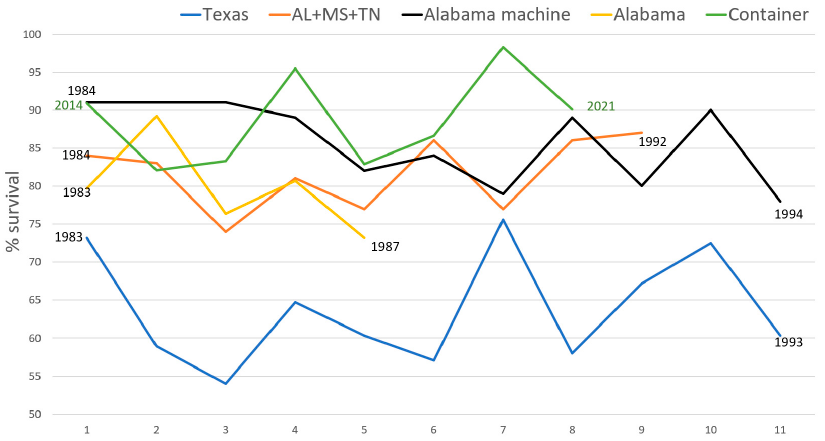
Figure 2. Average precipitation (1297 mm for years 2000 to 2021) for the southeast region of the USA (AL, FL, GA, SC, NC, VA) is about 45 mm greater now than 100 years ago. Since 1895, there have been 8 years with rainfall greater than 1500 mm, and 6 of those occurred after 1960.